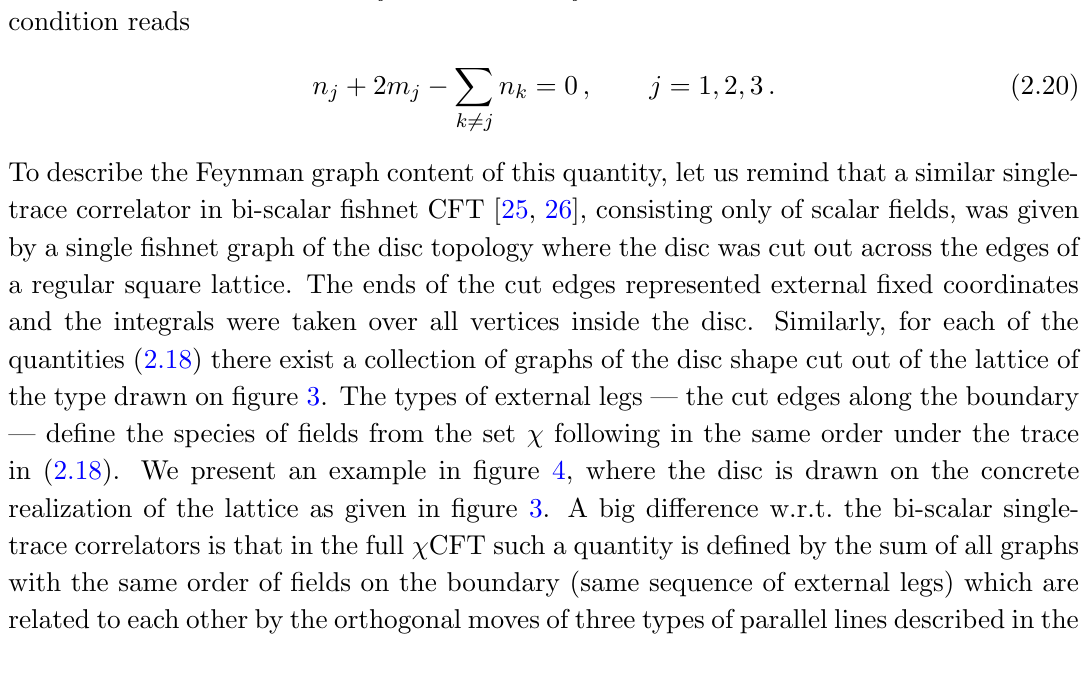
Figure 4 . The result of drawing a disc on the lattice of (cid:12)gure 3 can be interpreted as one planar graph contributing to an n -point functions of the kind (2.18), drawn in terms of e(cid:11)ective vertices. In this example we present Tr[ (cid:30) 1 (cid:22) 3 1 (cid:22) 3 2 (cid:30) y graph is of order (cid:24) 42 . As it results from table 1, each e(cid:11)ective vertex can be replaced in a univocal way in terms of structure made of real